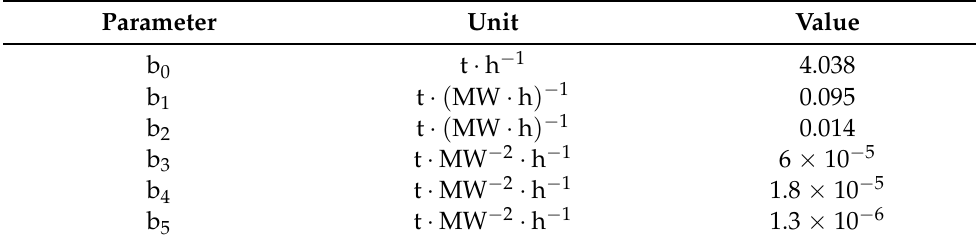
Table 1. Cost coefficients of CHP